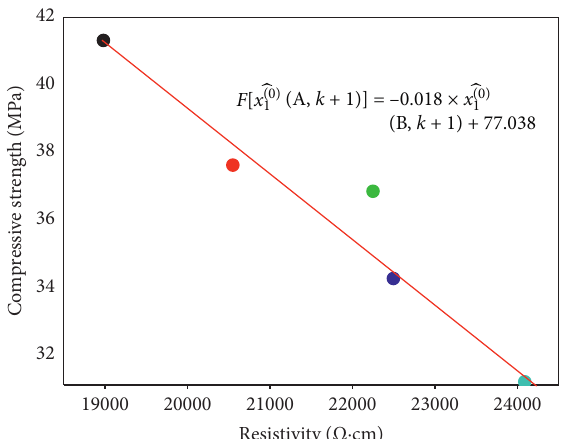
Figure 17: The relationship between the mechanics and resistivity of GTC based on grey